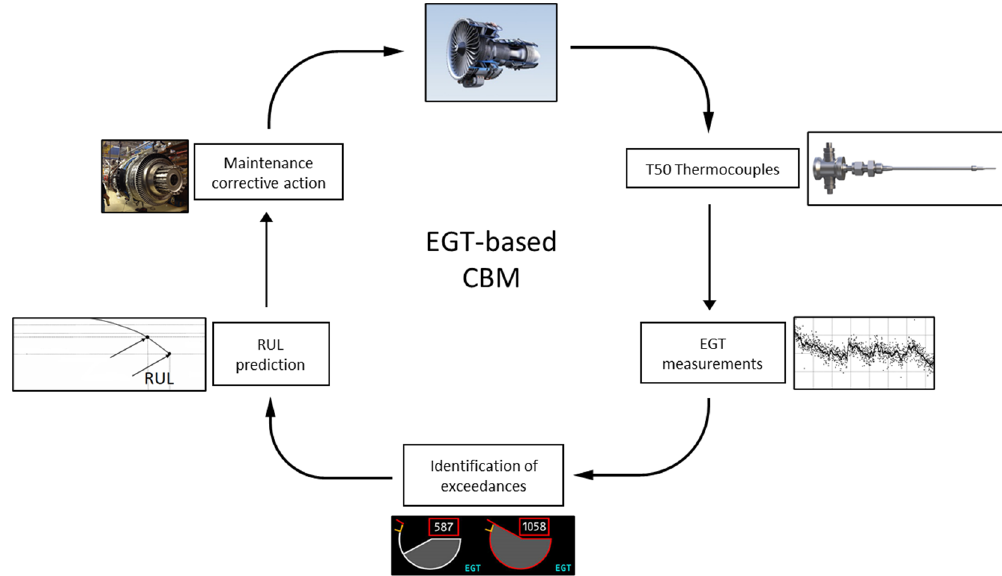
Figure 2. Conceptual EGT-based CBM process steps.